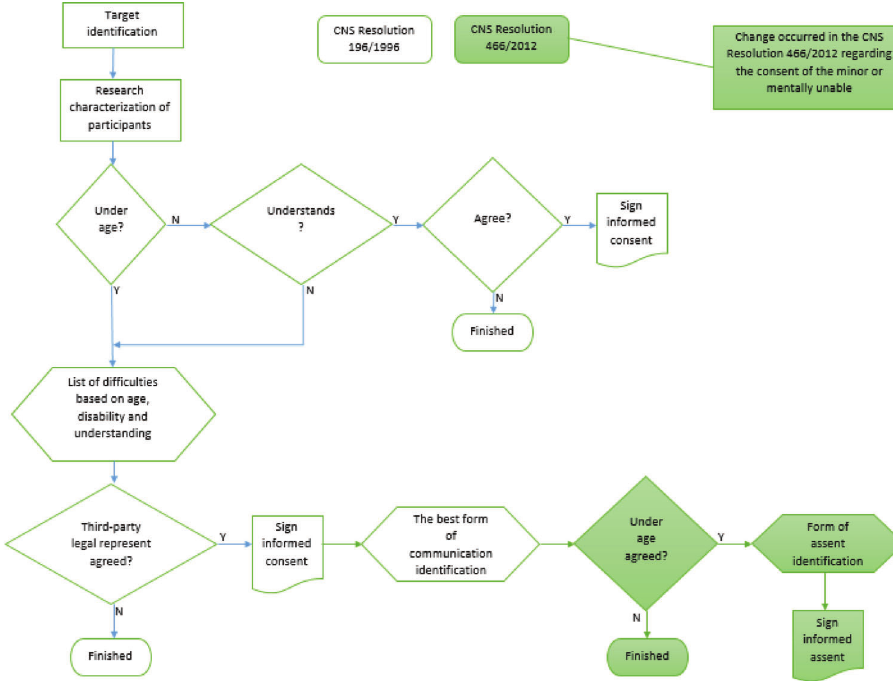
Figure 1 - Flowchart for the identification of the target group for the